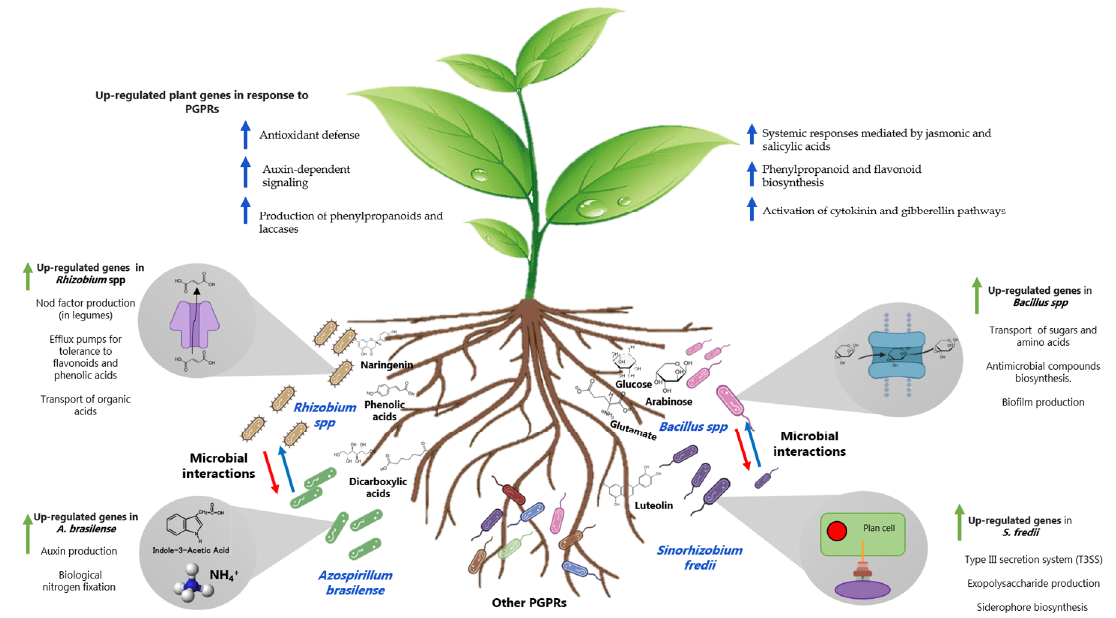
Figure 2. A transcriptomic view of plant–bacteria interaction. In poor soils, the plants activate a “cry for help” system which attracts microorgan- isms with outstanding metabolic capabilities. Root exudates can activate genes of PGPRs involved in root attachment and colonization, including those encoding secretion systems, fimbriae, flagella, plant wall-degrading enzymes (cellulases, xylanases, pectinases, and endoglucanases), and quorum-sensing systems [102,103]. Some secretion systems act as a molecular syringe that releases their effectors into the plant cell, weakening the immune response and promoting bacterial entry [104]. When Bradyrhizobium japonicum USDA 110 and Sinorhizobium fredii HH103 sensed root flavonoids, they expressed a type III secretion system (T3SS) necessary to establish effective nodulation and nitrogen fixation with soy- bean ( Glycine max ) [105]. Likewise, the type VI secretion system (T6SS) of Rhizobium etli Mim1 is essential for symbiosis with common beans [106]. Secretion systems also play an important role in PGPRs for interaction with cereals. The nitrogen fixer Azoarcus sp. BH72 expressed genes encoding a T6SS and pili in response to rice exudates. Mutants in these genes are deficient in root invasion [107]. The genes encoding T3SS, endoglucanases, and polygalacturonases were activated in R. phaseoli in the presence of maize exudates [100]. In contrast, when this bacterium colonized the rhizoplane, it expressed a T6SS secretion system [108]. A fascinating dual transcriptomic/proteomic study to determine key genes for adaptation to an endophytic lifestyle revealed that Nitrospirillum amazonense expressed a type IV secretion system and RND efflux pumps for toxic compounds in sugarcane apo- plast [109]. Root exudates are rich in nutrients and have phytoalexins, flavonoids, phenolic acids, and alkaloids with antimicrobial activity [92]. The abundance of these compounds in the rhizosphere shapes the assembly of microbial communities [110]. PGPRs carry mecha- nisms for detoxifying plant metabolites through degradation, neutralization, or excretion. Work on rhizosphere-associated Pseudomonas, including P. fluorescens , P. brassicacearum , P. chlororaphis , P. protegens , and P. synxantha showed an overexpression of genes for the cleavage of catechol, benzoate, and phenolic acids in interaction with the grass Brachypo- dium distachyon [111] and sugarbeet [112]. Rhizobium etli CFN42 harbors an efflux pump, RmrAB, that confers tolerance to naringenin, phaseollin, phaseollidin, coumaric acid, and salicylic acid [113] (Figure 2). In the phytopathogen Pseudomonas syringae pv. tomato